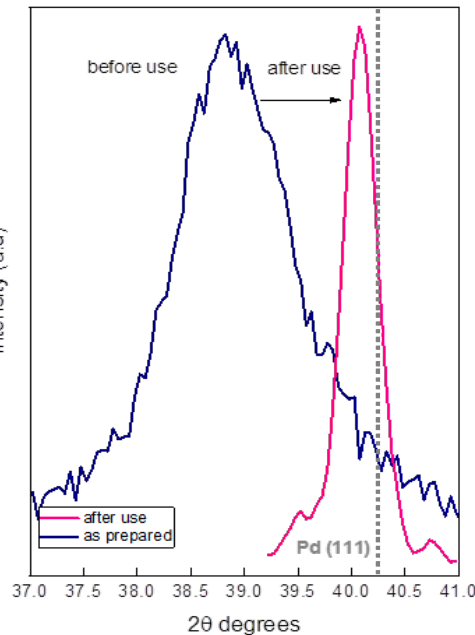
Figure 9. X-ray diffractograms of the as-prepared and used 65C catalyst.